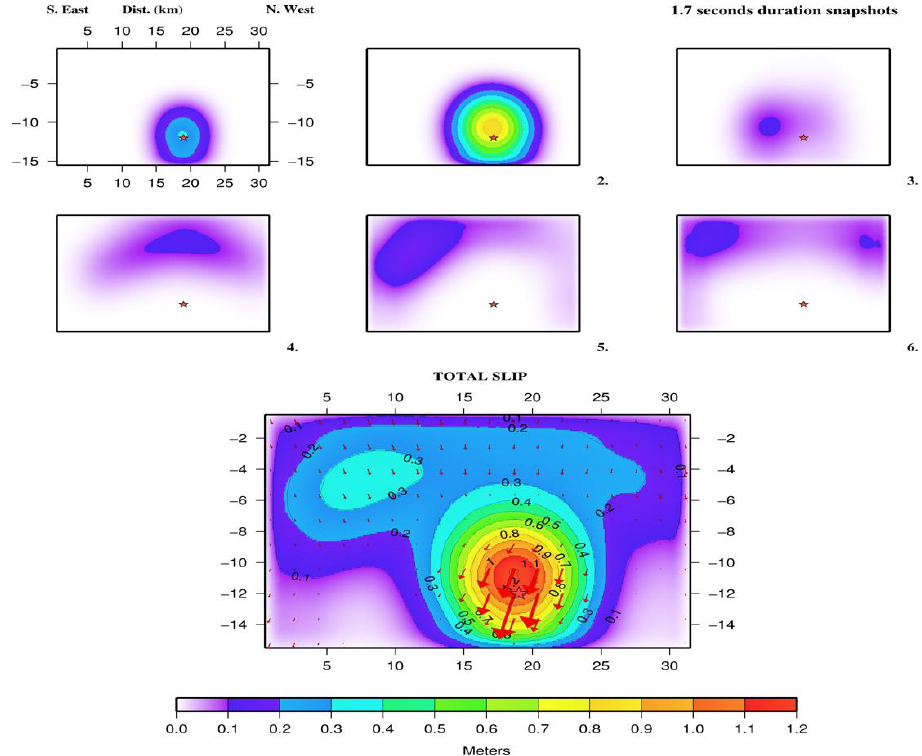
Figure 6. Snapshots showing the space–time evolution of slip upon the fault which is striking at 138° and dipping northeast; star denotes the hypocenter, fault plane dimension is in km, slip contours are in m. Slip amplitude in m is shown in color and the motion direction, i.e., the rake angle, of the hanging wall relative to the footwall, is indicated with red arrows showing direction and amplitude of slip.